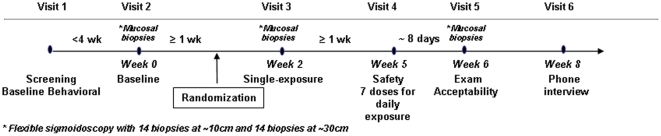
Study Flow Diagram.